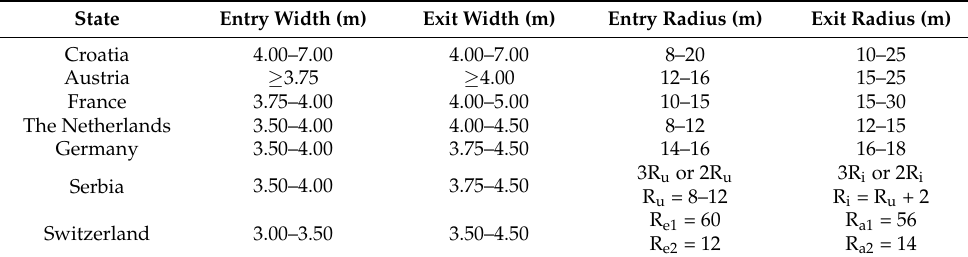
Table 7. Design elements for roundabout entry and exit according to